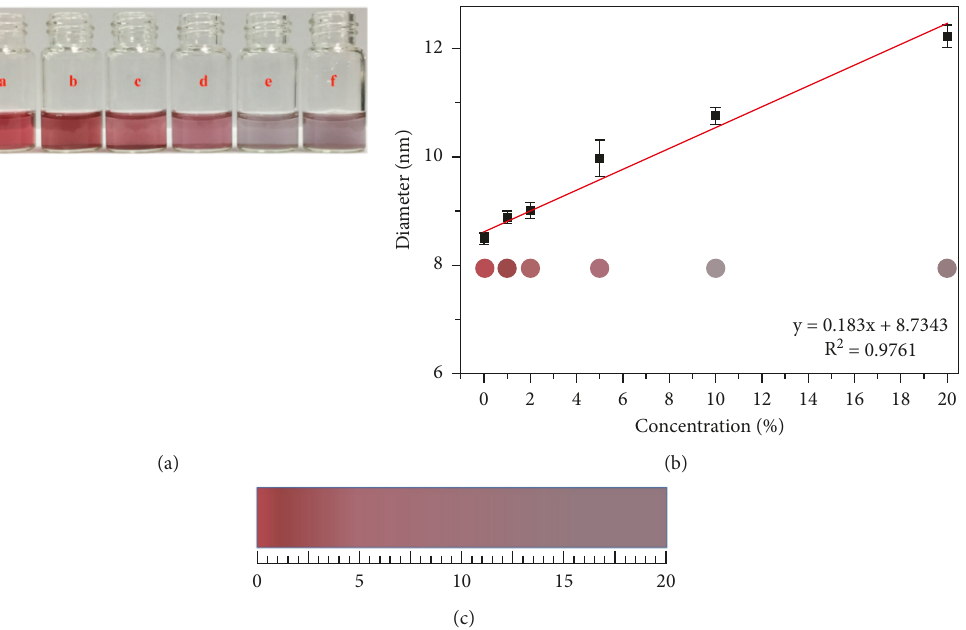
Figure 4: The relationship between concentration of different adulterants and particle size of AuNPs and solution color. (a) A–F represent the color of the AuNP mixture solution at the concentration of 0%, 1%, 2%, 5%, 10%, and 20% adulterants, respectively. (b) The linear fitting diagram of the concentration of different adulterants against the particle size of AuNP mixtures. (c) According to the relationship between the concentration of different adulterants and the color of the solution-produced color card. ( R 2 � 0.9761).